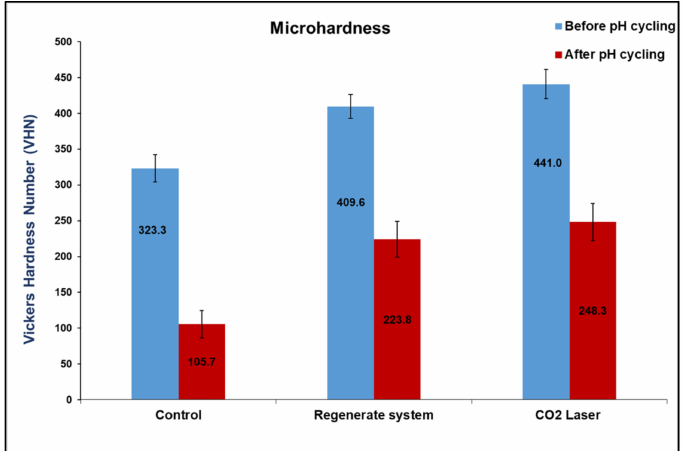
Figure 4. Mean values of Vickers microhardness number (VHN) of the control, Regenerate-treated group, and CO 2 laser-treated group before and after pH-cycling. The laser-treated group exhibited the highest VH values before and after pH-cycling, followed by Regenerate system ( p <